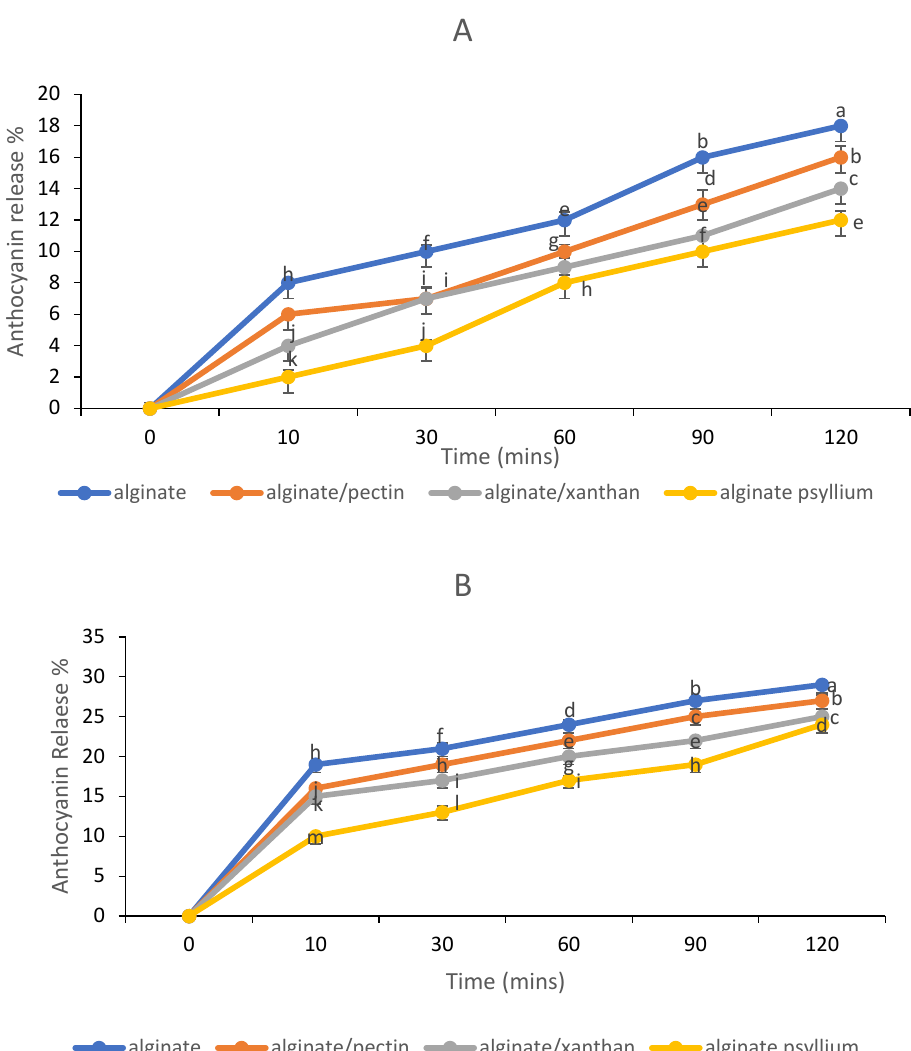
Figure 6. ( A ) gastric release and ( B ) intestinal release of anthocyanins from alginate beads. During the intestinal phase, the integrity of the alginate beads was maintained for the first 10 min, but, after that, the amount of anthocyanin extract released from the beads increased (Figure 6B). During a 2 h incubation in SIF, the beads released some of the entrapped anthocyanins (24–29%). The release profiles of all types of alginate beads in SIF were found to be identical although alginate/psyllium beads showed a delayed-release. As can be seen, the mechanism of release in SIF differed from that of